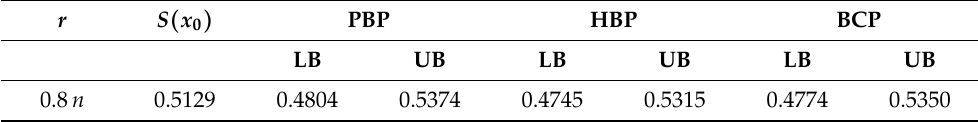
Table 9. 95% confidence intervals of the survival function at x 0 = 39 for